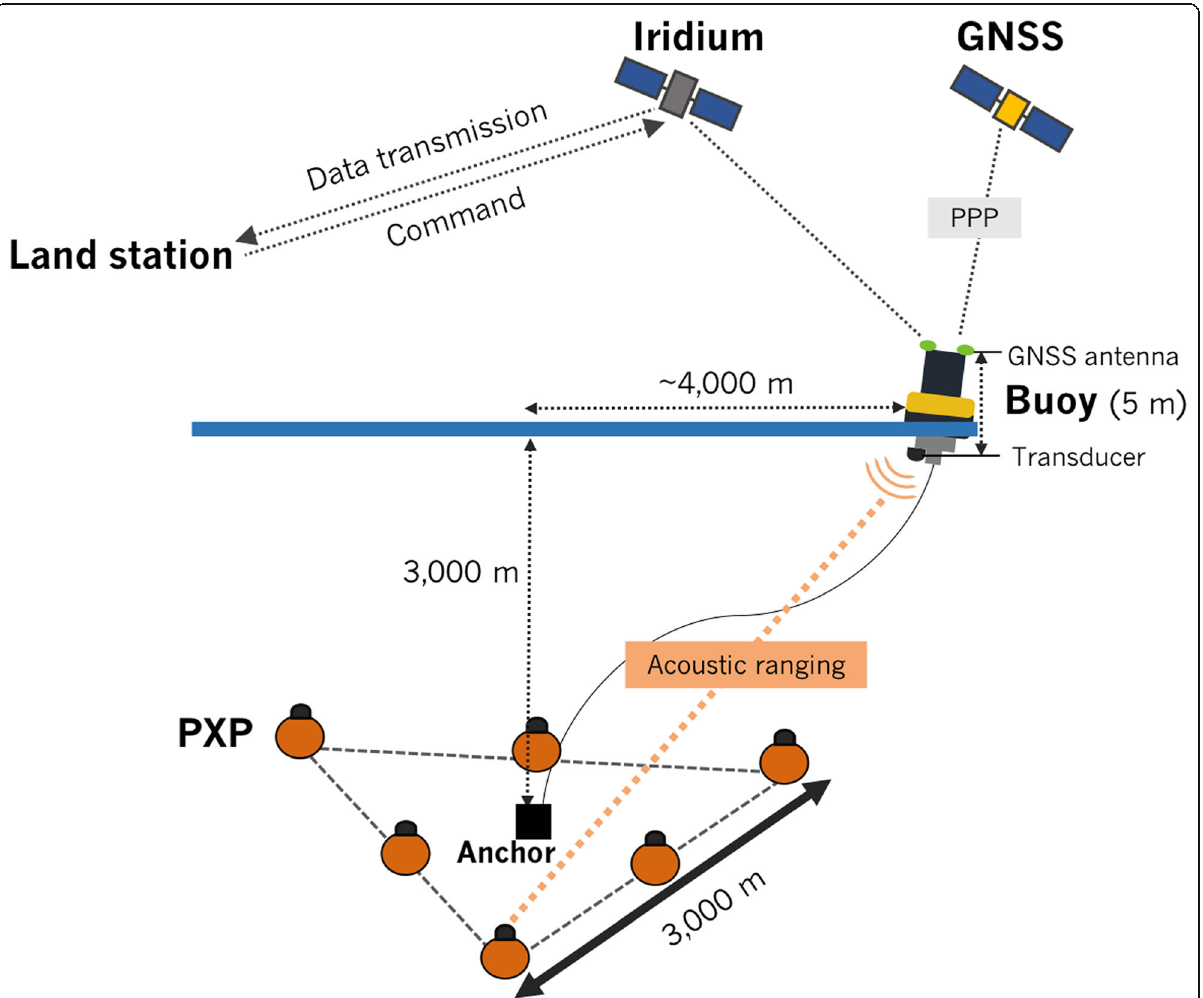
Fig. 1 Schematic illustration of GNSS-A seafloor positioning using a slackly moored buoy system. The buoy is moored with an anchor (approximately 6 tons) using a sufficiently longer rope (4700 m) than the depth (3000 m) near the center of the PXP array, which consists of six PXPs aligned in a triangle. A sequence of GNSS-A observations is carried out automatically at preset intervals (11 shots/week) or on demand from a land-based station. At the end of a measurement sequence, the data are transmitted to the land-based station via Iridium satellite